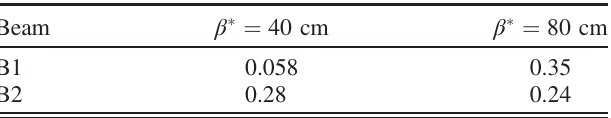
TABLE VIII. SIXTRACK predictions of the fraction of impacts at d < 50 μ m in the TCT jaws. The hits in horizontal and vertical TCTs are summed. The values correspond to the first bins in the left plots of Fig. 12.